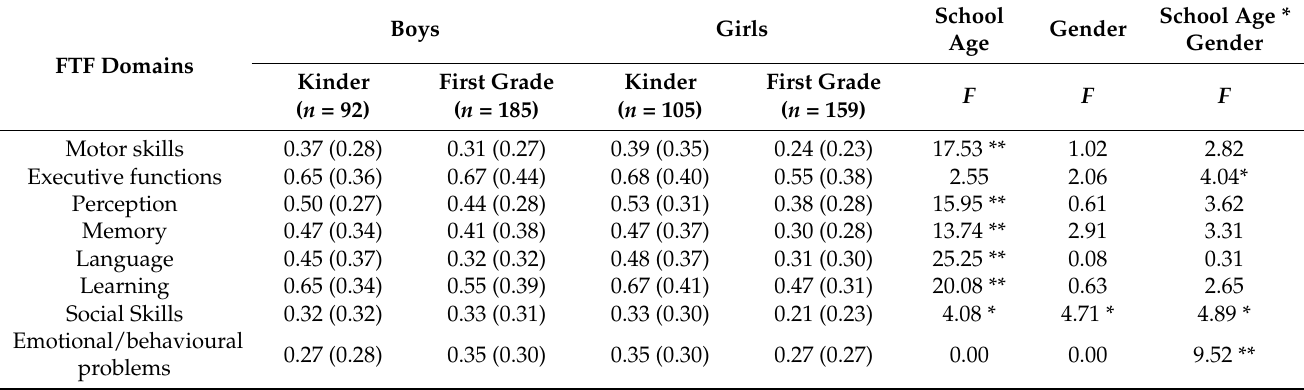
Table 5. Means and Standard Deviations (SD) for Domains, by School Age and